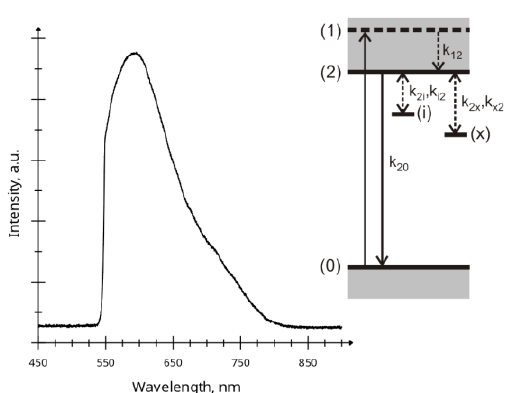
Fig. 1. Luminescence spectra of CdSe cores only QDs on the left, and suggested energy levels on the right (0 – valence band, 2 – conducting band, 1 – some energy level in conducting band, i – “shallow” traps, x – "deep" traps, k – speed